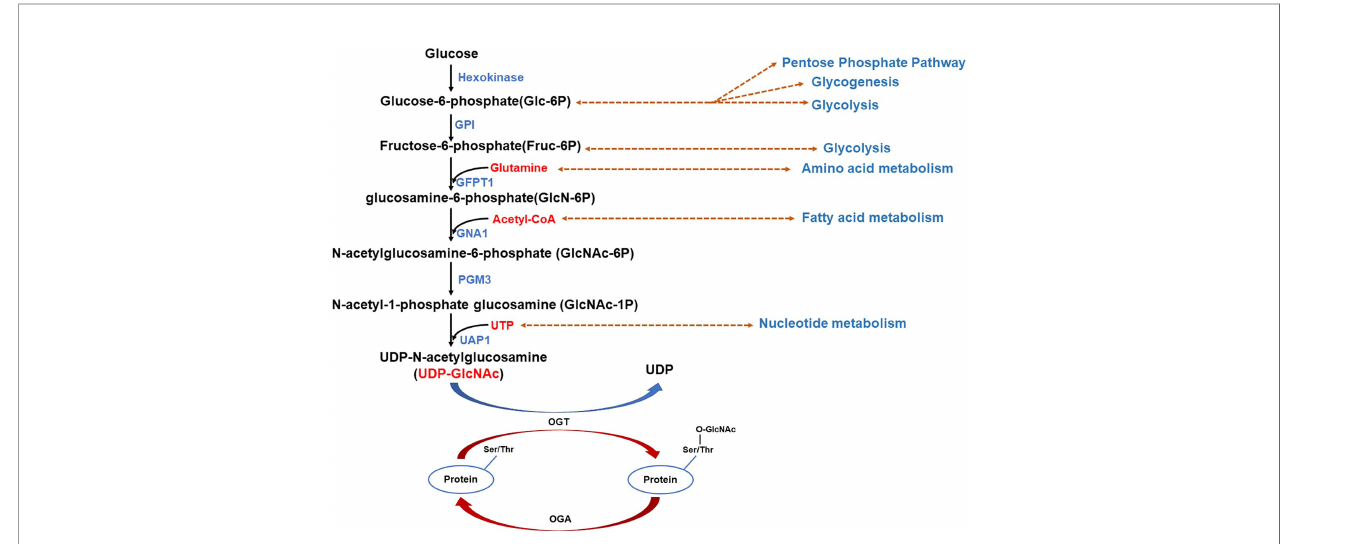
FIGURE 1 | Schematic illustration of the hexosamine biosynthesis pathway (HBP) integrating different metabolic intermediates fl uxing to UDP-N-Acetlyglucosamine (UDP-GlcNAc). Glucose is phosphorylated by hexokinase yielding glucose-6-phosphate (Glc-6P) which can be converted to fructose-6-phosphate (Fruc-6P) by glucose-6-phosphate isomerase (GPI). Both Glc-6P and Fruc-6P can be metabolized by glycolysis or the HBP. The rate-limiting enzyme of HBP: Glutamine-fructose 6-phosphate aminotransferase (GFPT1 or GFAT) mediates the diverge to HBP, conversing Fruc-6P to glucosamine-6-phosphate (GlcN-6P) from glutamine, the amide donor. Additionally, GFAT mRNA and protein expression was upregulated by saturated fatty acids (palmitate and stearate), whereas inhibition occurs owing to feedback from its enzymatic product GlcN-6P. Next, acetyl-CoA (AcCoA) and GlcN-6P are converted by D-glucosamine-6-phosphate N-Acetyltransferase (GNA1) to CoA and N-Acetylglucosamine-6-phosphate (GlcNAc-6P). After that, another enzyme, GlcNAc phosphomutase (PGM3), converts GlcNAc-6P to N-Acetyl-1-phosphate glucosamine (GlcNAc-1P), employing glucose-1,6-bisphosphate as a co-factor. The nucleoside (UTP) is then added to the sugar by UDP-N-Acetylhexosamine pyrophosphorylase (UAP1) yielding UDP-N-Acetlyglucosamine(UDP-GlcNAc). Glucose-6-phosphate isomerase (GPI); Glutamine-fructose 6-phosphate aminotransferase (GFPT1 or GFAT); D-glucosamine-6-phosphate N-Acetyltransferase (GNA1); GlcNAc phosphomutase (PGM3); Nucleoside (UTP); UDP-N-Acetylhexosamine pyrophosphorylase